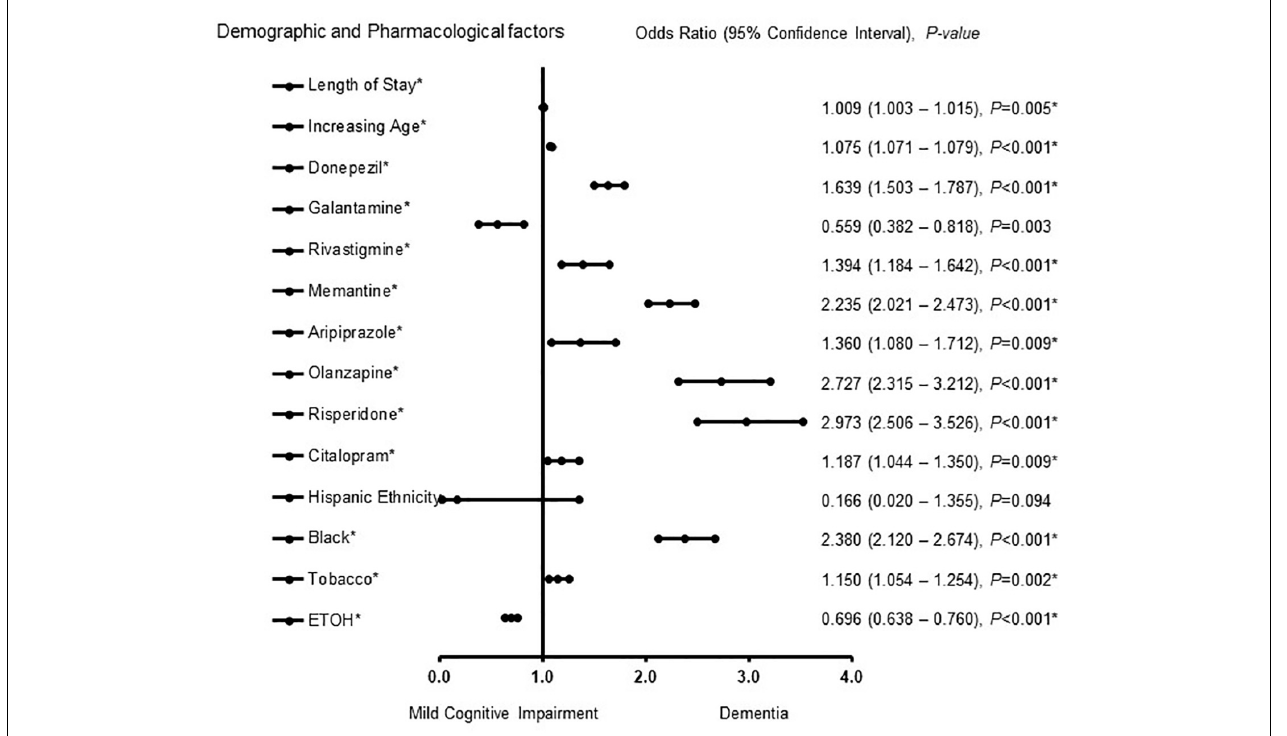
FIGURE 1 | Demographic and pharmacological factors associated with mild cognitive impairment and Alzheimer patients with dementia in males. Adjusted OR < 1 denote factors that are associated with mild cognitive impairment while OR > 1 denote factors that are associated with dementia. Hosmer-Lemeshow test ( P < 0.001*), Cox & Snell (R 2 = 0.217). The overall classified percentage of 76.6% was applied to check for fitness of the logistic regression model. *Indicates statistical significance ( P < 0.05) with a 95% confidence